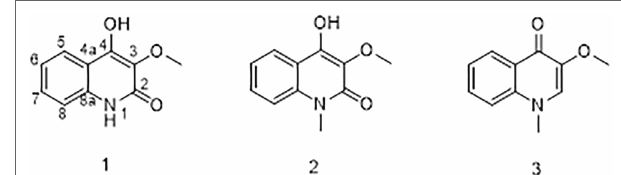
FIGURE 5 | Structures of compounds